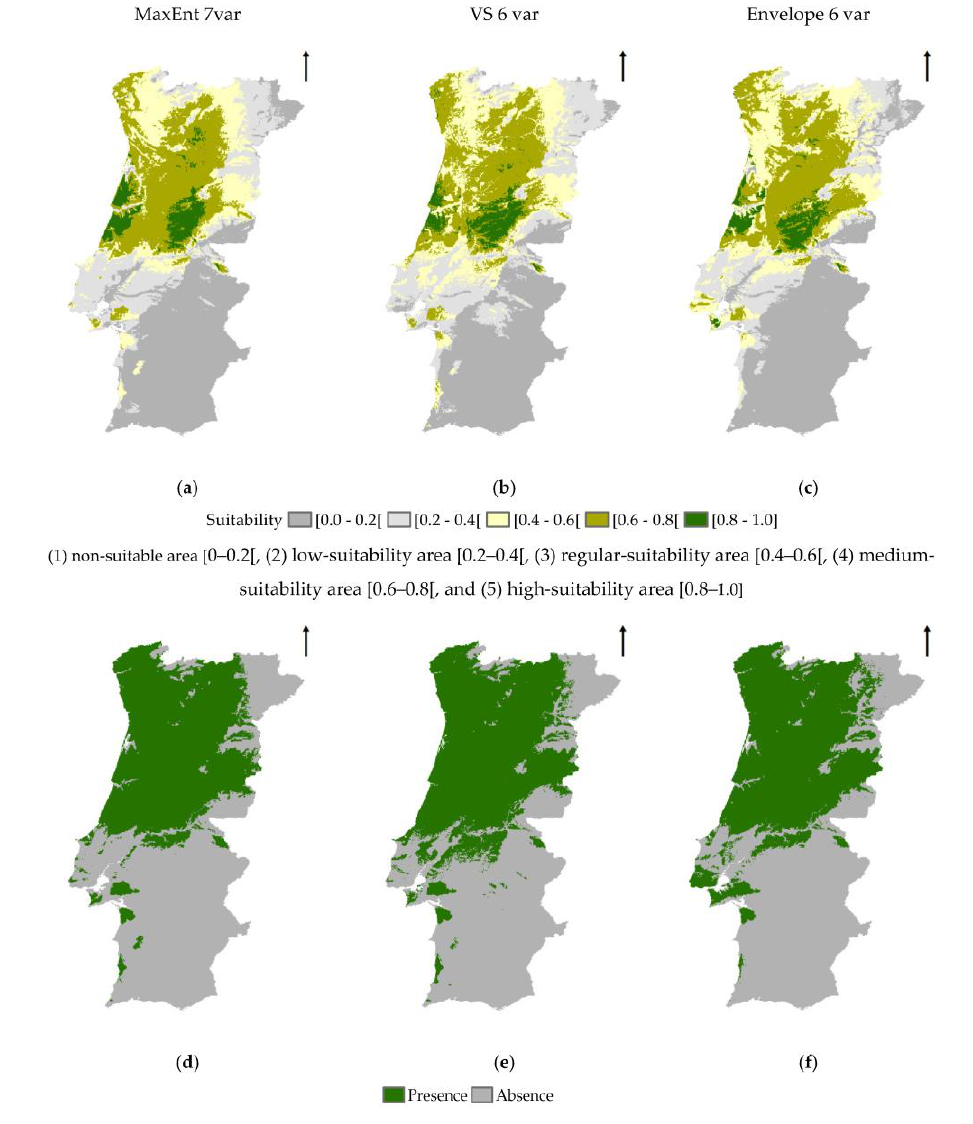
Figure 5. MaxEnt simulation procedures—Maritime pine potential distributions for the present (suitability classes and presence–absence maps): ( a ) MaxEnt software selection module (MaxEnt 7 var); ( b ) Virtualspecies R package (VS 6 var); ( c ) ecological envelope variables (Envelope 6 var); ( d ) presence – absence map (MaxEnt 7 var); ( e ) presence – absence map (VS 6 var); and ( f ) presence – absence map (Envelope 6 var).